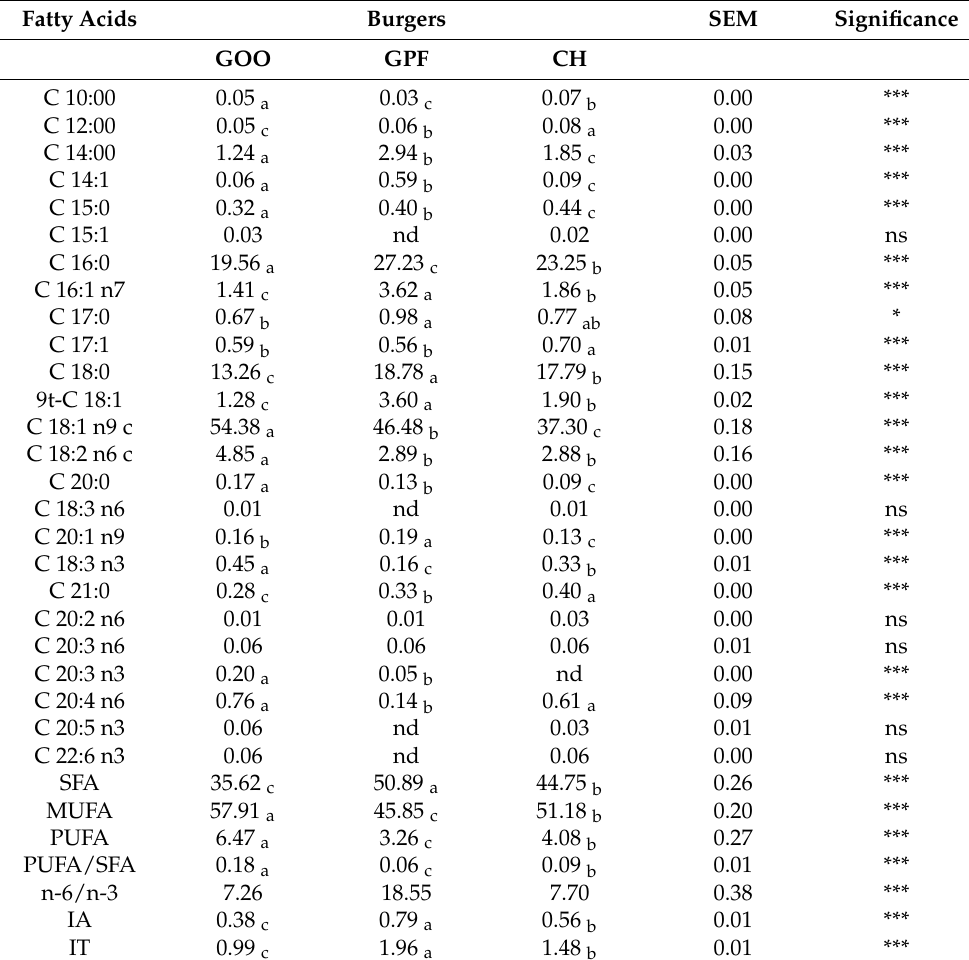
Table 4. Effects of fat replacement by olive oil on the fatty acid profile (expressed in g/100 g of fatty acids) of goat meat burgers as compared with commercial beef